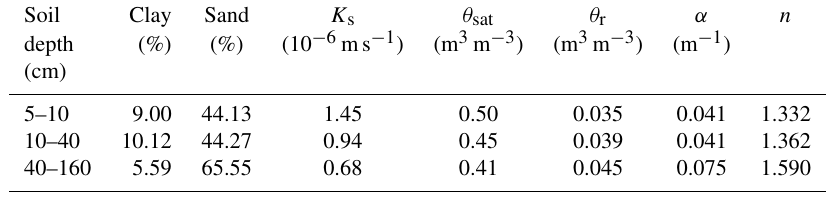
Table 2. The adopted average values of soil texture and hydraulic properties at different depths (see the Appendix for the notations). Soil